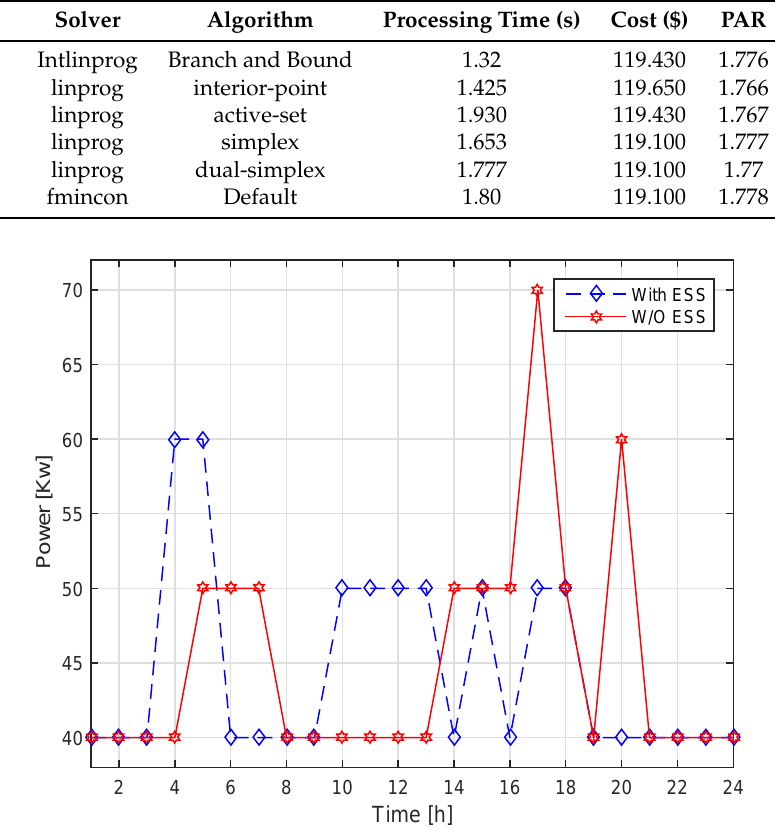
Figure 8. Aggregated power with and without ESS of user1 and user2 respectively.